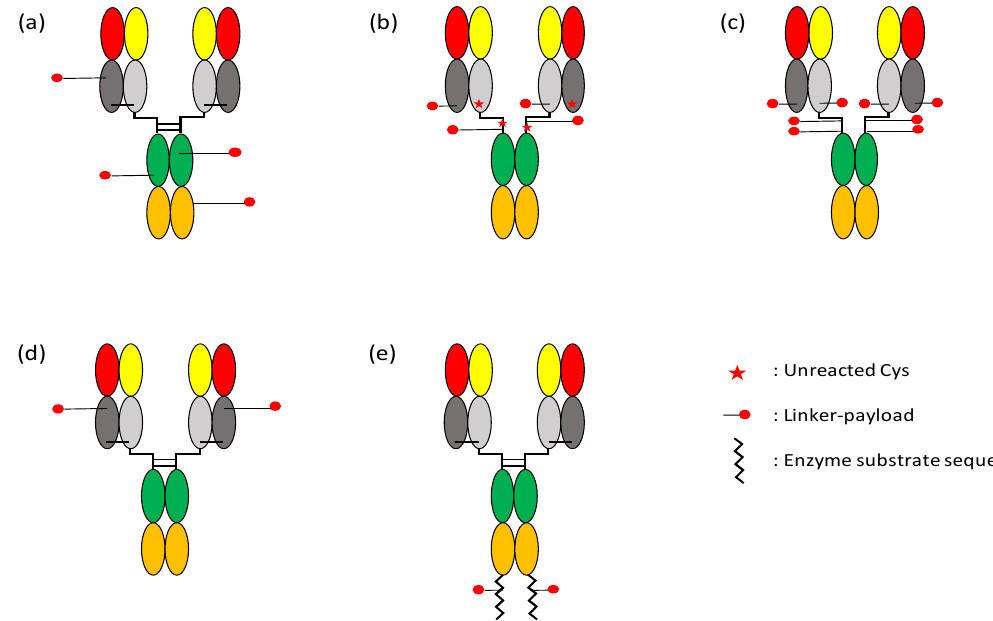
Figure 4. Graphics of representative ADCs with different conjugation methods. ( a ) Random conjugation to primary amines, with hypothetical drug-to-antibody ratio (DAR) = 4. ( b ) Cysteine conjugation after the reduction of interchain disulfide bonds, with hypothetical DAR = 4. ( c ) Complete cysteine conjugation with DAR = 8 (e.g., trastuzumab deruxtecan). ( d ) Site-specific conjugation by the introduction of e.g., cysteines or non-natural amino acids, DAR = 2. ( e ) Site-specific enzymatic conjugation to the introduced substrate sequence, DAR = 2.